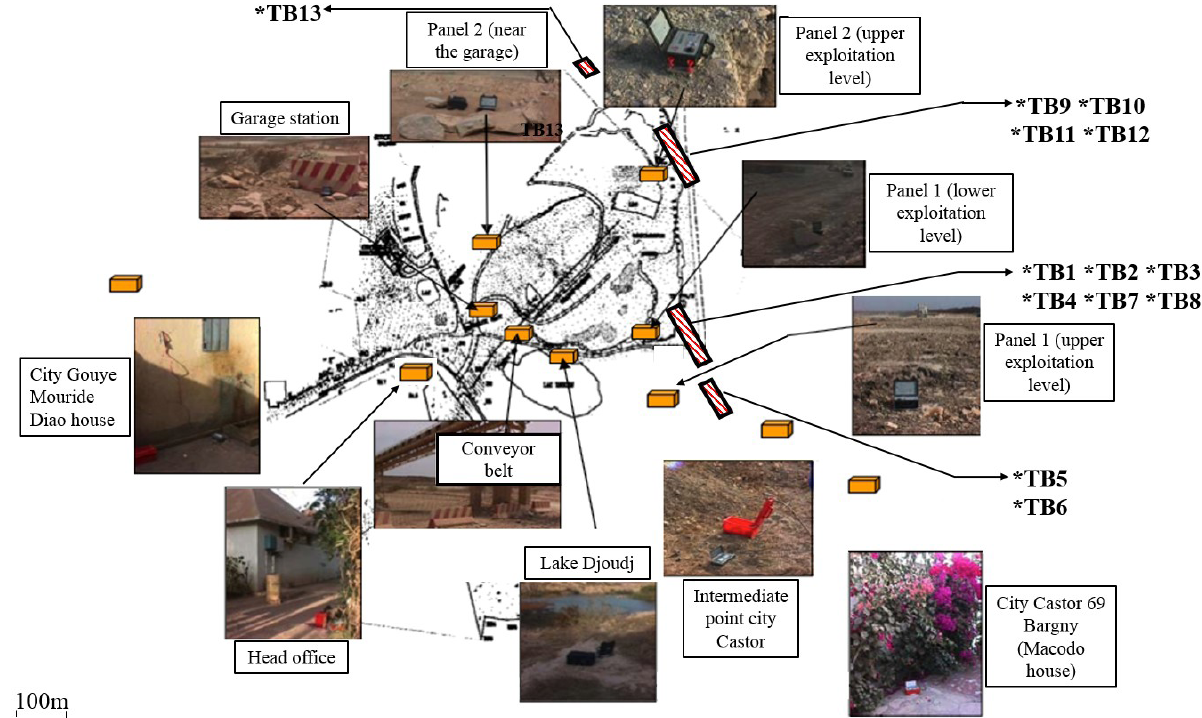
Figure 3: Blast’s location and the assessed measurement